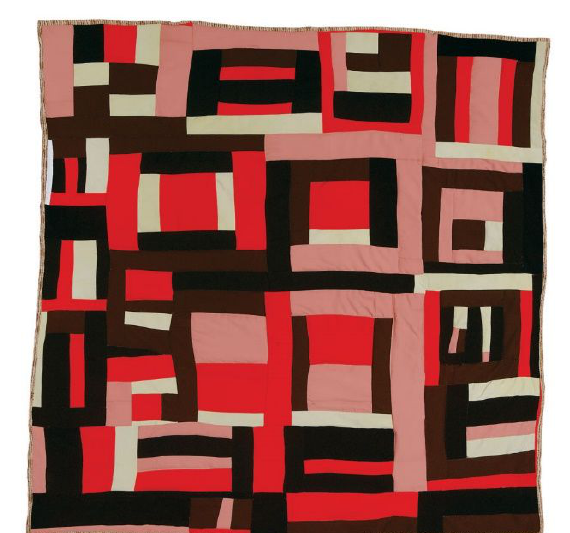
Figure 28. Rachel Carey George, “Housetop —Sixteen-Block ‘Half-Log Cabin’ Variation Sashed With Feed Sacks,” ca. 1935. © 2022 Estate of Rachel Carey George / Artists Rights Society (ARS), New York. Photo by Stephen Pitkin/Pitkin Studio courtesy of Souls Grown Deep